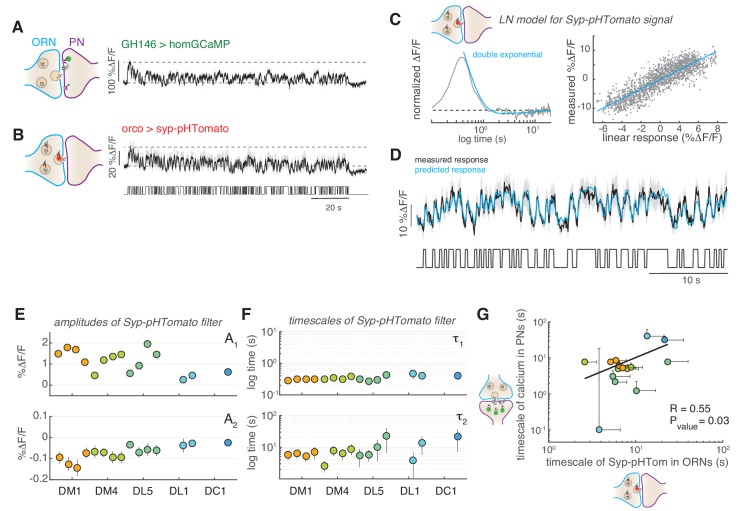
Slow adaptation in the PN calcium signal reflects slow depression in vesicle release at the ORN terminals.(A) Postsynaptic calcium signal in PNs measured with dHomer-GCaMP from glomerulus DM1 in response to a fluctuating odor stimulus. The gray-shaded area represents SEM. (B) Fluorescence signal of Syp-pHTomato from ORNs in DM1. (C) LN model for the Syp-pHTomato signal. Left: Normalized linear filter fitted to the data in (E) (gray) and exponential fit to the linear filter (cyan, double exponential). Right: Scatter plot of the predicted linear response and measured response (gray) and corresponding linear fit (cyan). (D) Mean Syp-pHTomato fluorescence (black, as in (C)) and response predicted by the LN model (cyan). (E) An LN model was fitted to all responses measured in five glomeruli (color coded as before) at four stimulus concentrations. The BIC was used to choose whether the linear filter shape was better captured by a simple exponential or a double exponential function. In all cases, a double exponential was selected k3t=A1e-tτ1+A2e-tτ2 with A1 >0 and A2 <0 (see also Figure 6—figure supplement 1). The response of DL1 to C01 and C08 and the response of DC1 to C01, C08, and C13 were too weak to fit a model. (F) The timescales of the negative exponential τ2 are always slower than that of the positive exponential τ1, indicating a slow adaptive process. (G) The slow timescale τ2 of the Syp-pHTomato signal correlates with the timescale of the slow adaptation measured in the calcium signal of postsynaptic PNs (Figure 4G). Different colors indicate different glomeruli. Error bars indicate 95% confidence intervals.